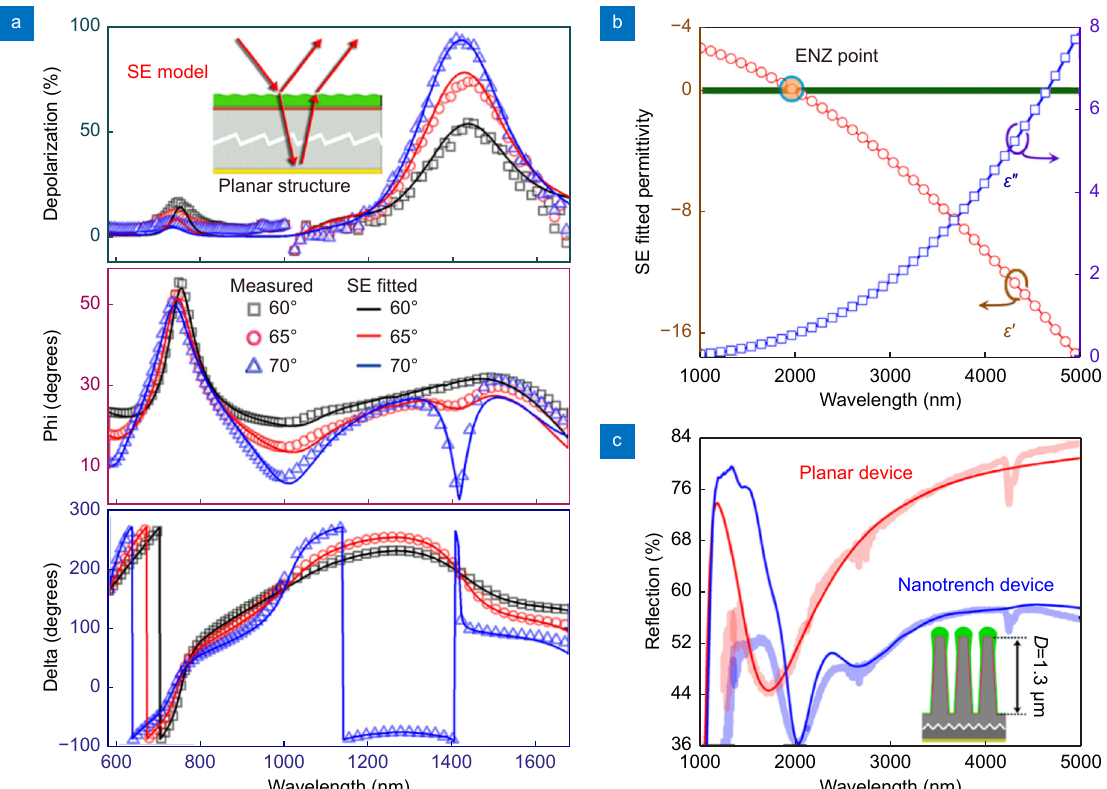
Fig. 3 | ( a ) The measured and fitted SE data of the planar reference structure with different incidence angles. The complete structure represen- ted in SE model as a multilayered system (Inset of the top plot). ( b ) Optical constants of the PLD deposited AZO film based on the SE fitting. The derived values for the Drude model parameters are: high frequency permittivity ε ∞ =3.806, carrier density N 0 =3.3×10 20 cm −3 and damping rate γ =1.39 ×10 14 s −1 . Based on the SE model, the thickness of the AZO film and HfO 2 is found to be 343 and 10 nm, respectively. ( c ) Spectral fitting results of the nanostrench and the planar reference devices. The thick and thin curves represent the experimental and fitted results, respectively. Note that, the non-polarization response of nanotrench device is averaged by two orthogonal linear